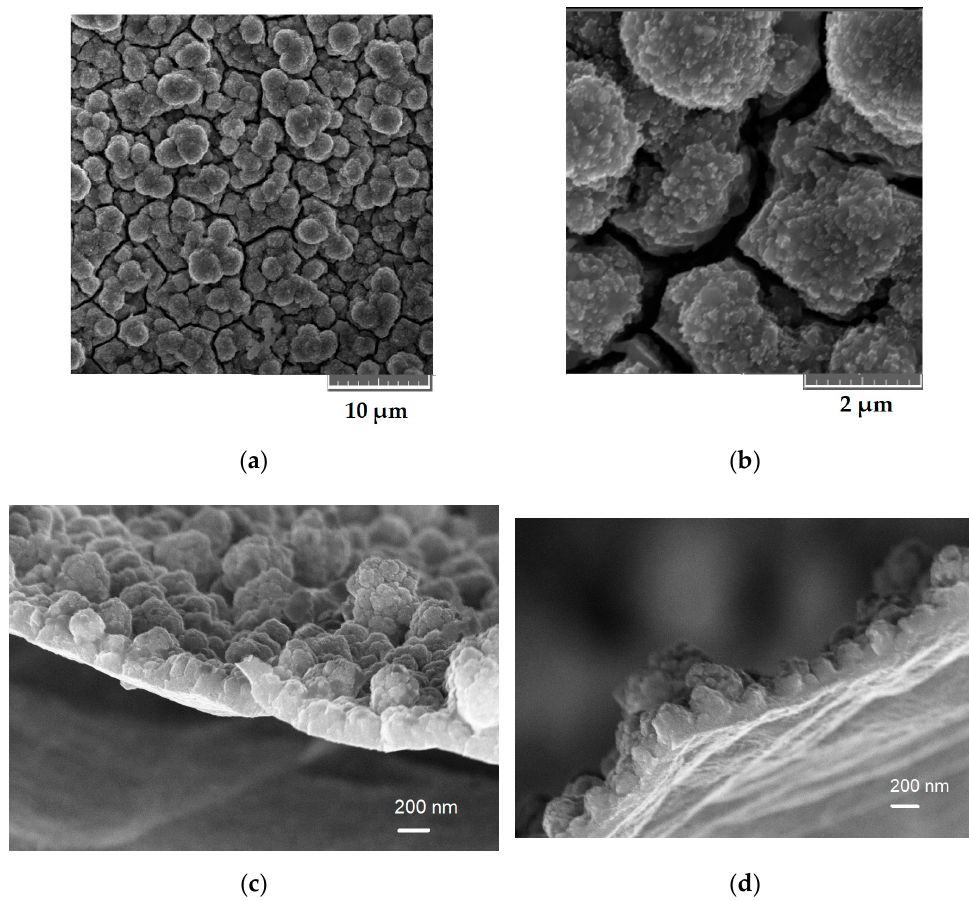
Figure 2. SEM images of Ge-Co-P nanostructures at various magnifications: ( a , b )—frontal image; ( c , d )—cross section image.